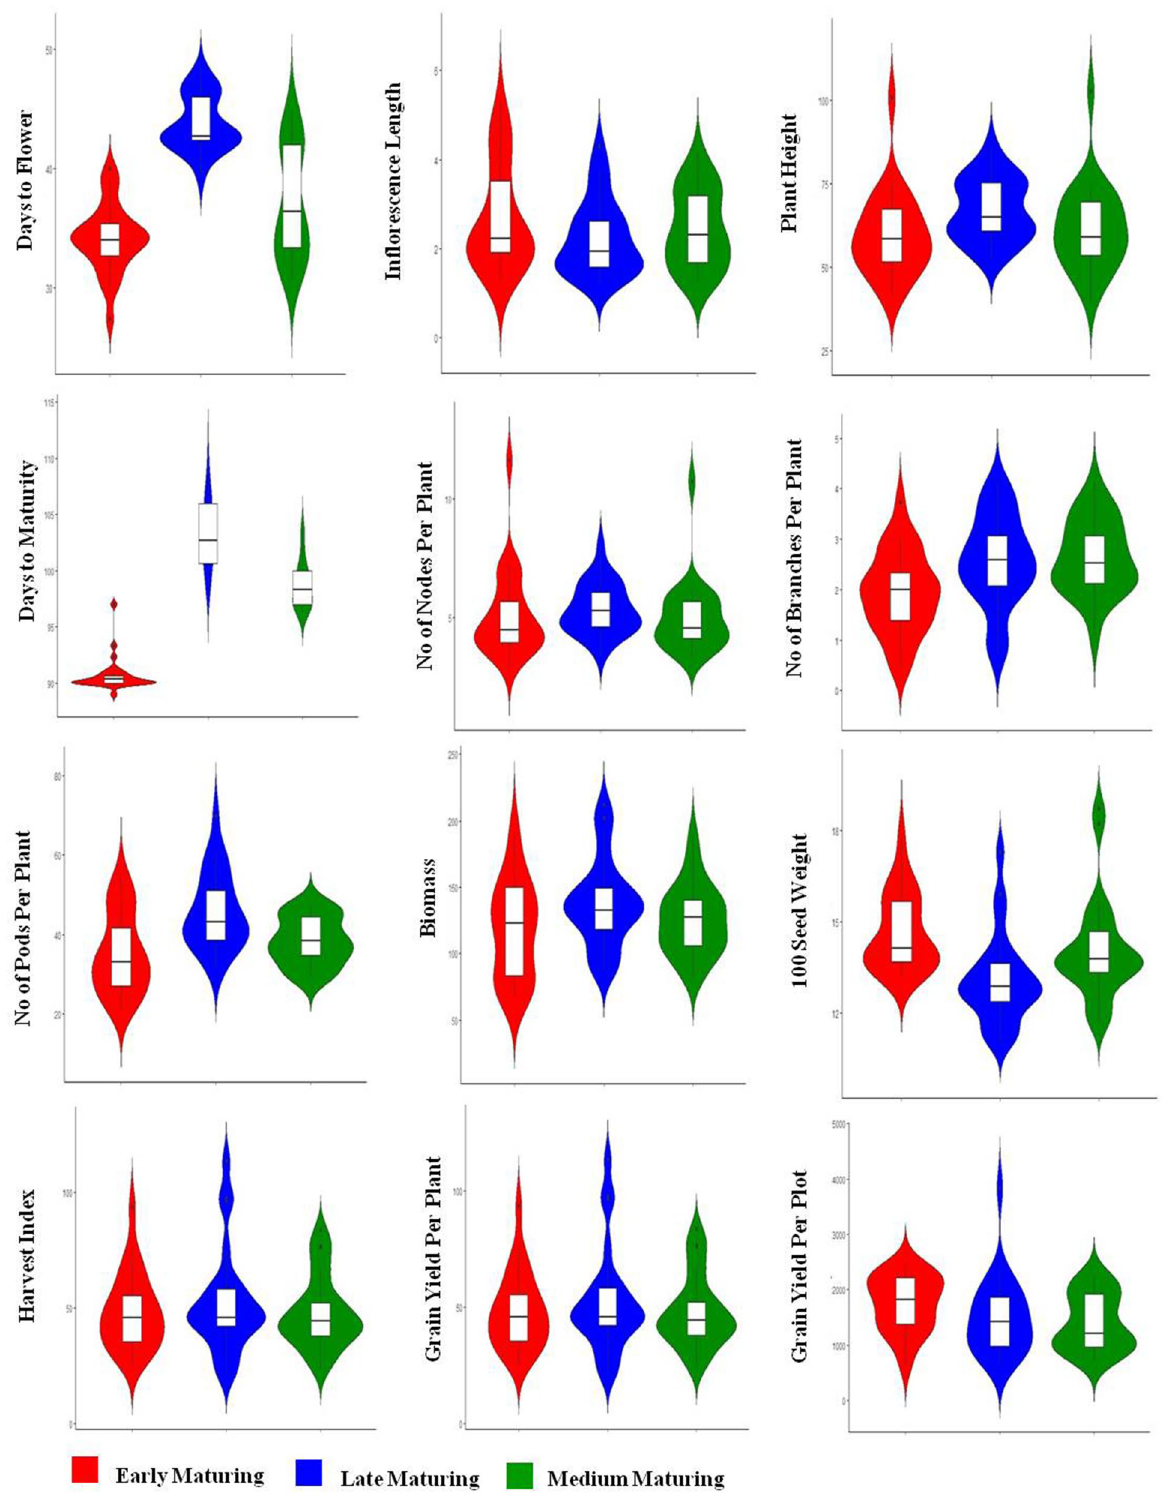
Figure 1. Depiction of genetic variation through violin plots for different quantitative traits in early, medium and late maturing breeding